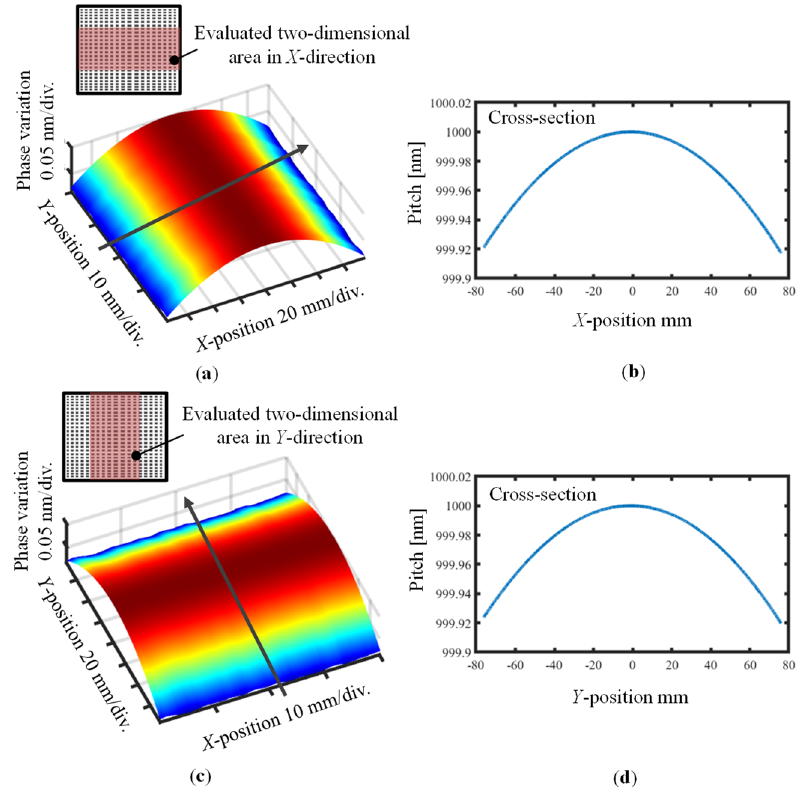
Figure 16. Evaluated two-dimensional pitch variations of the large-scale VLS grating: ( a ) X -directional two-dimensional pitch variations; ( b ) X -directional central cross-section pitch distribution; ( c ) Y -directional two-dimensional pitch variations; ( d ) Y -directional central cross-section pitch distribution. Table 1. Evaluated VLS parameters of the large-scale VLS grating. (One cross-section analysis). Table 2. Evaluated VLS parameters of the large-scale VLS grating. (Two-dimensional area